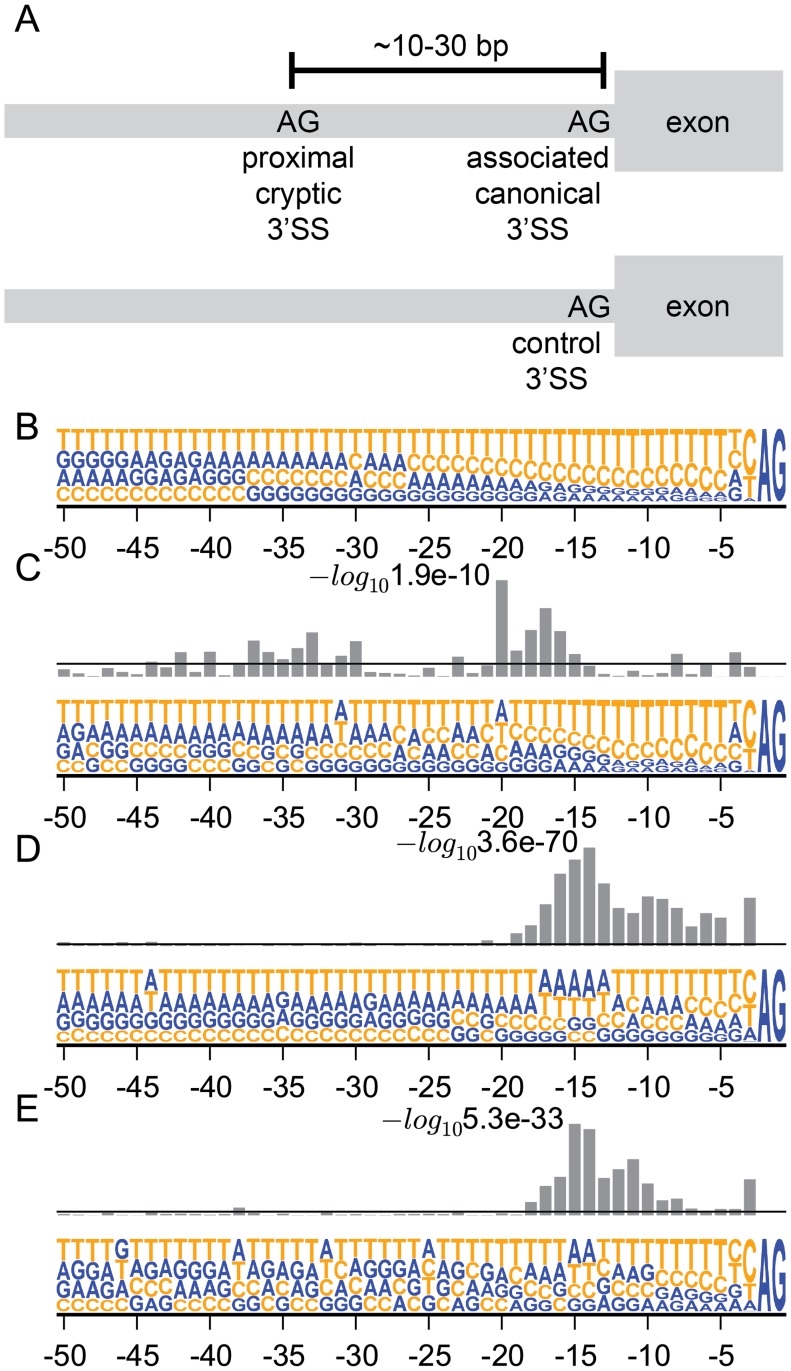
3’ intron nucleotide composition for control, associated canonical, and cryptic 3’SSs.(A) We identified 23,066 control 3’SSs whose junctions had a mean coverage greater than 100 reads over all CLL, BRCA, and UM samples to compare to the cryptic and associated canonical 3’SSs. Nucleotide frequency for the last 50 bp of the intron for (B) 23,066 control 3’SSs; (C) 613 associated canonical 3’SSs; (D) 619 proximal cryptic 3’SSs; and (E) 417 distal cryptic 3’SSs. Bar plots above each nucleotide composition plot are log10 p-values from Fisher exact tests for enrichment of adenines at each position relative to control 3’SSs. Horizontal line marks significance level of p = 0.05. (-log10 0.05 ≈ 1.3). The p-value box plots have different scales in (C), (D), and (E); the smallest p-values for each panel are labeled.